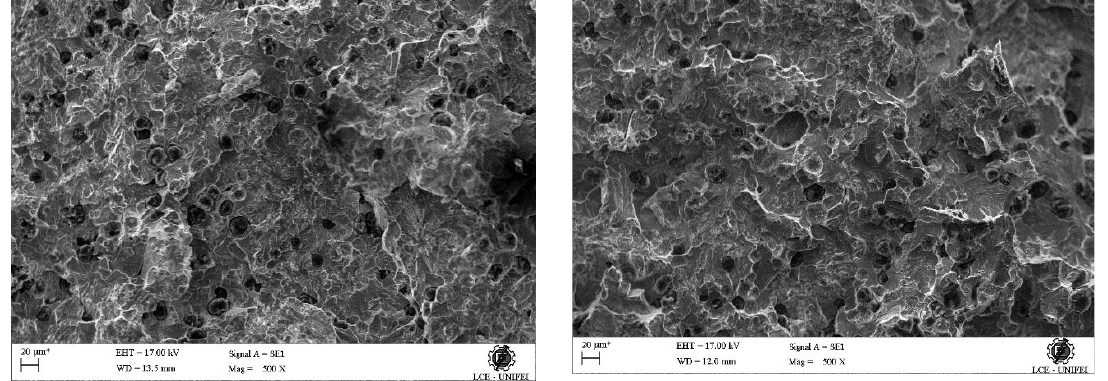
Figure 32. Fractured surface of Ni/Cr.